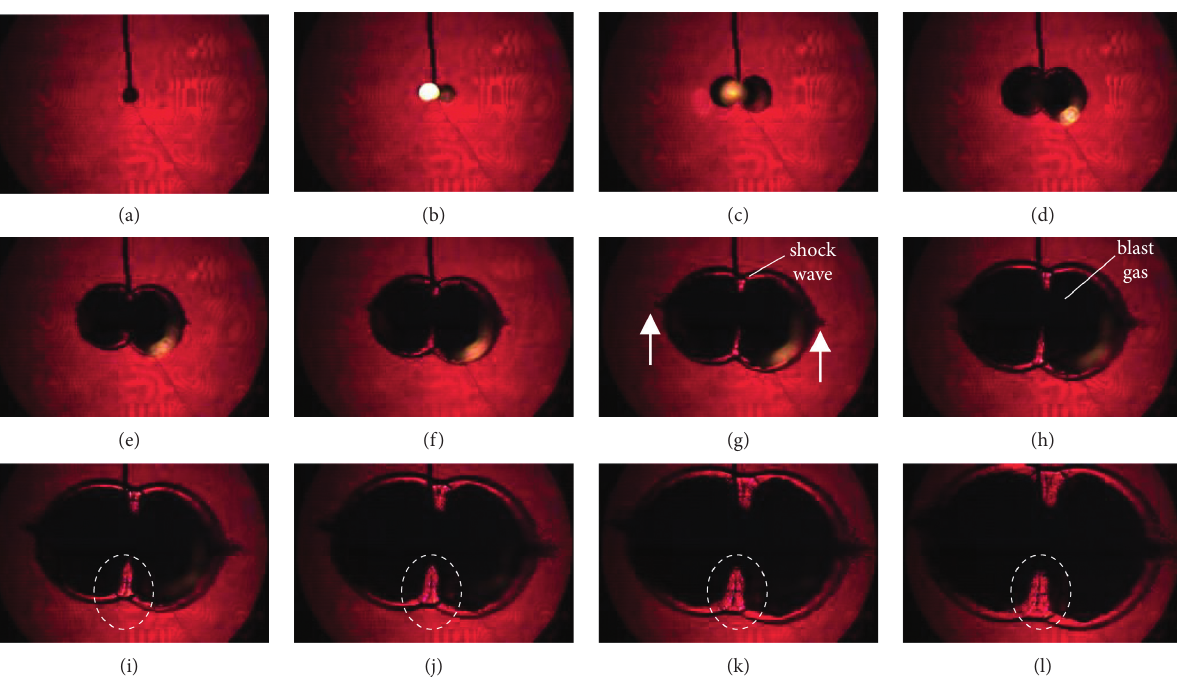
Figure 4: High-speed schlieren images for parallel orientation of the charge (parallel to laser light). (a) 0 μ s, (b) 10 μ s, (c) 20 μ s, (d) 30 μ s, (e) 40 μ s, (f) 50 μ s, (g) 60 μ s, (h) 70 μ s, (i) 80 μ s, (j) 90 μ s, (k) 100 μ s, and (l) 110 μ